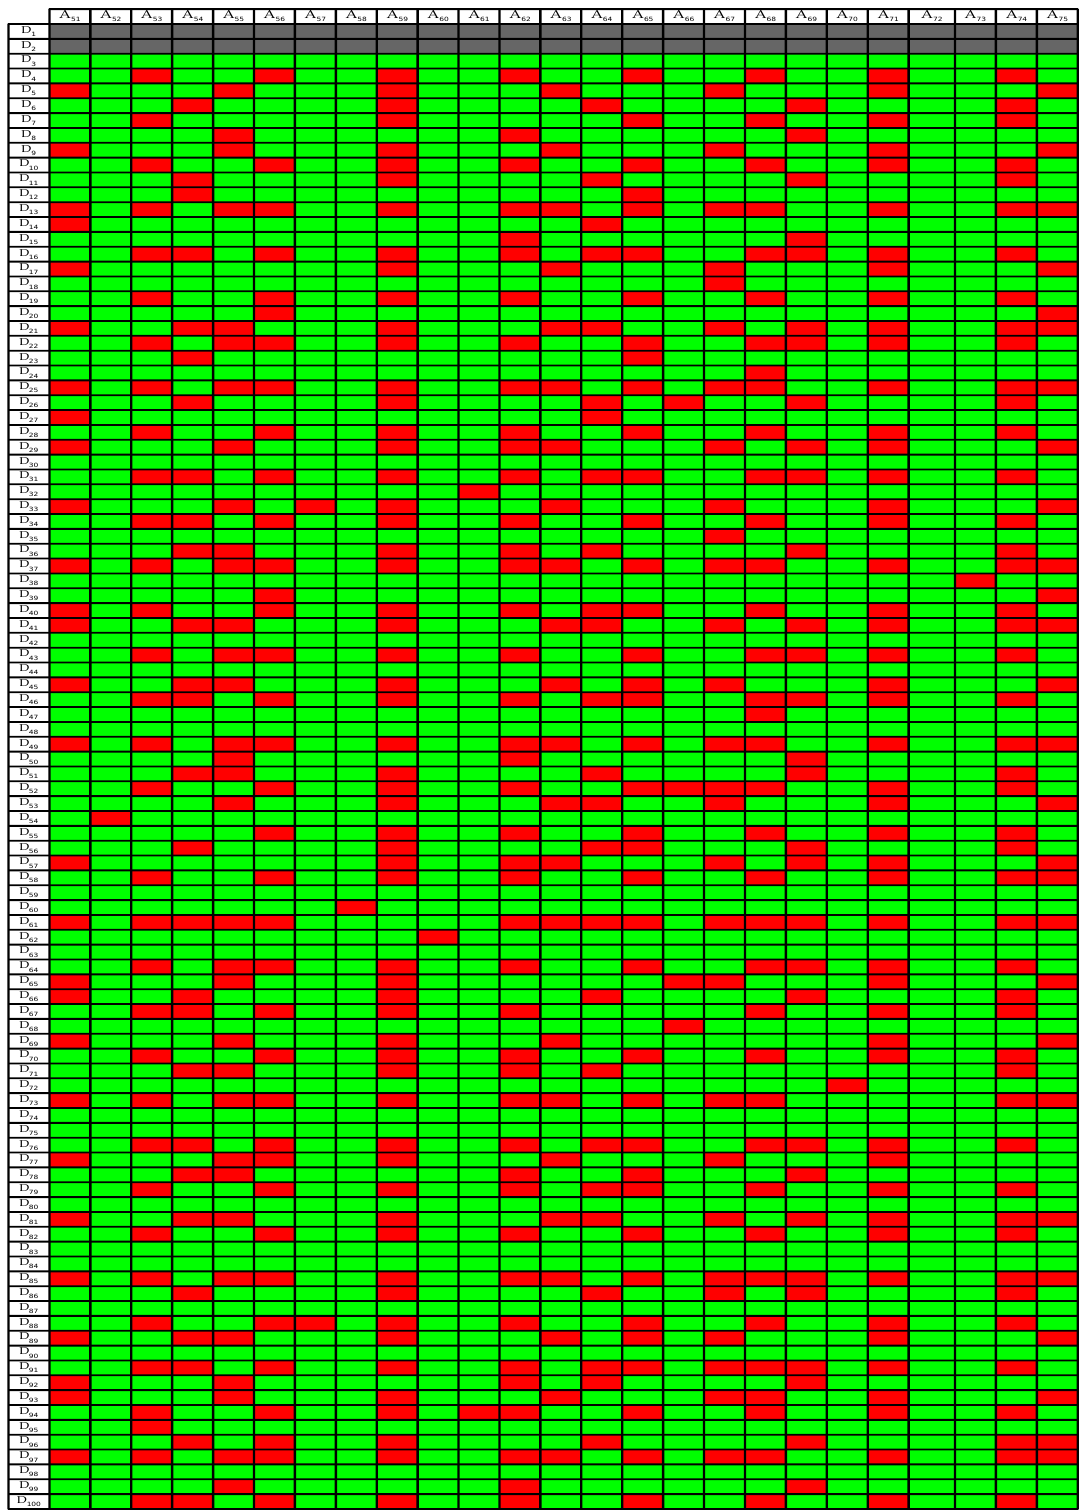
Table 8 . Analyzed theories for ( D n ; A m ) with n = 3 ; : : : 100 and m = 51 ; : : : 75.